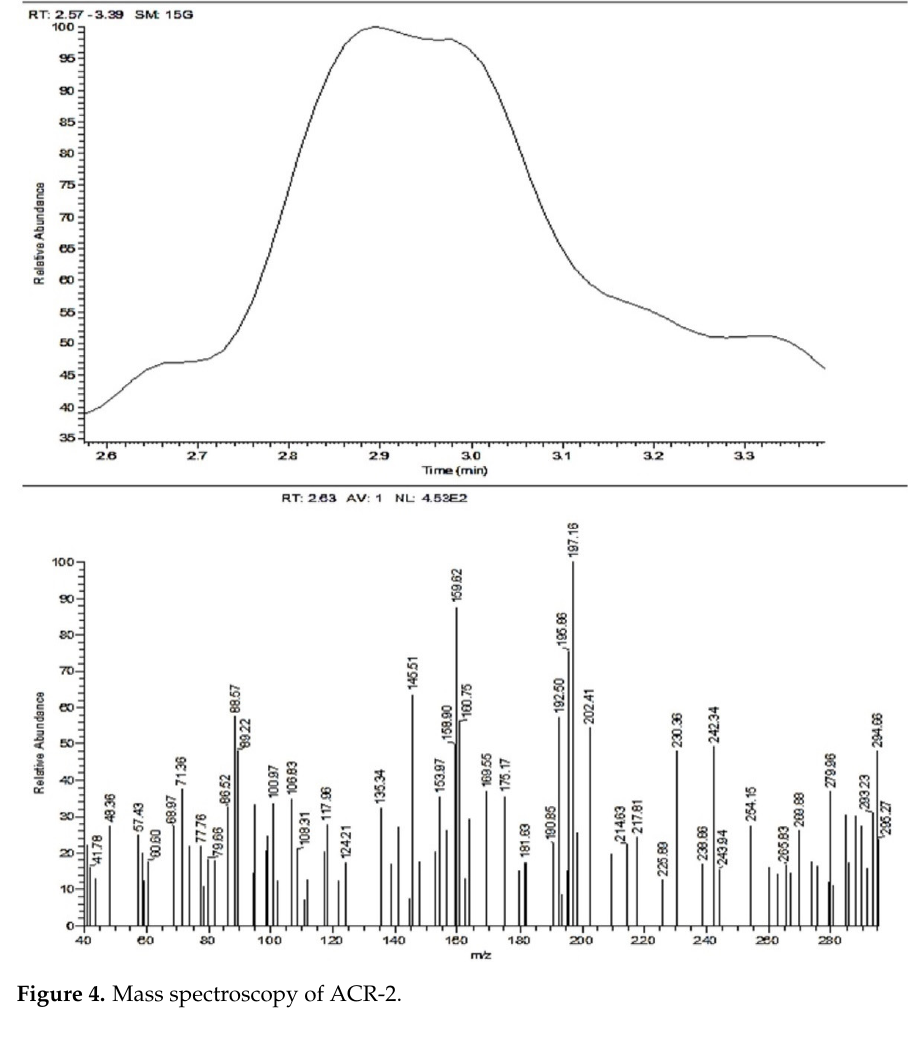
Figure 4. Mass spectroscopy of ACR-2.